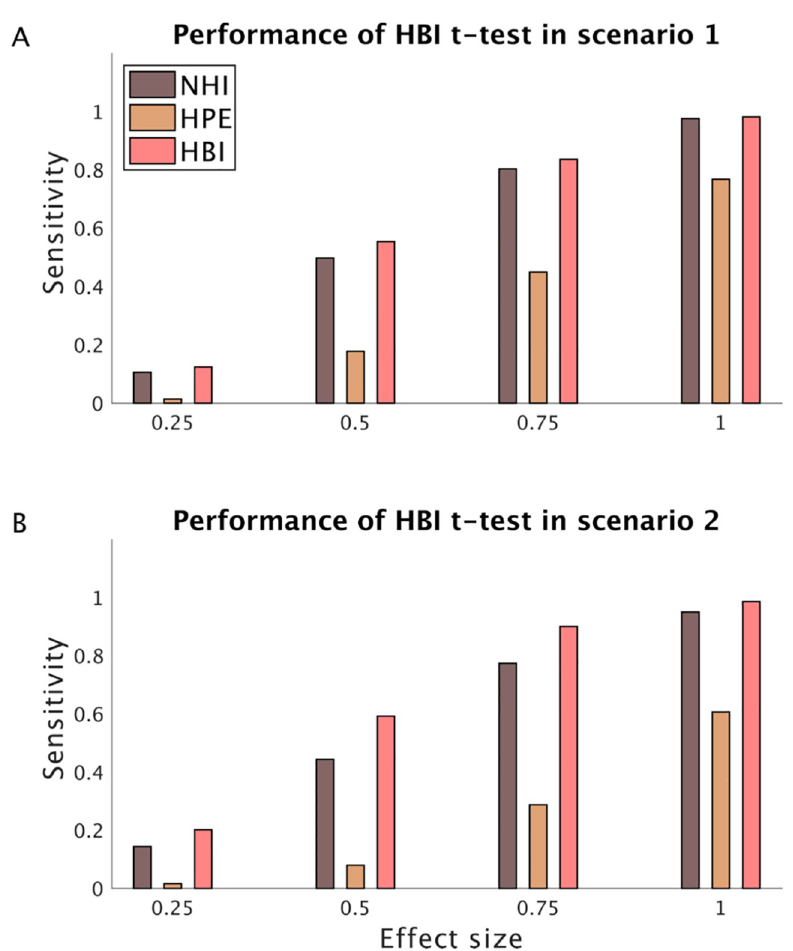
Fig 10. Performance of the HBI t-test for making inference at the population level. RL agents with a bias parameter were generated according to different mean (effect size) values in two simulations where A) there is only one model in the model-space (scenario 1); or B) there are two models in the model-space (scenario 2). The HBI makes inference using the HBI t-test, the NHI makes inference by performing a t-test on its estimated parameters and the HPE makes inference by comparing the full fit and null fit (in which the group-level prior mean for the bias parameter is fixed). The sensitivity (or power) of the tests in detecting true effects at P < 0.05 for a number of different effect sizes is plotted (i.e. true positive rate). For the HPE, log-evidence of at least 3 was considered as significant. The HPE shows lower sensitivity than the other methods in both scenarios. Moreover, the HBI shows higher sensitivity than the NHI in scenario